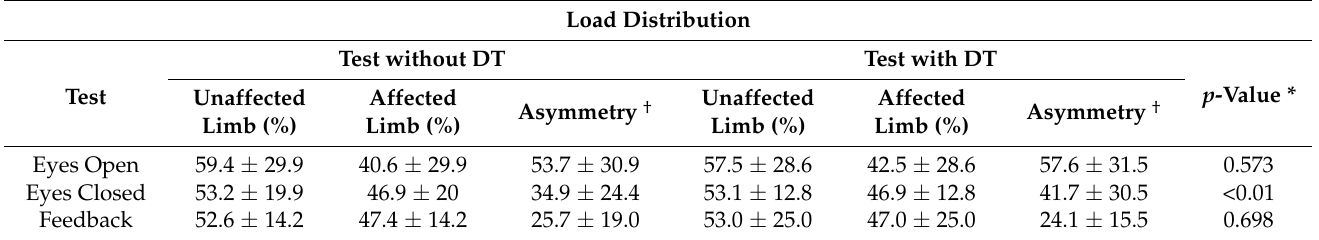
Table 2. Load distributions between affected and unaffected limbs on a stable surface. Load